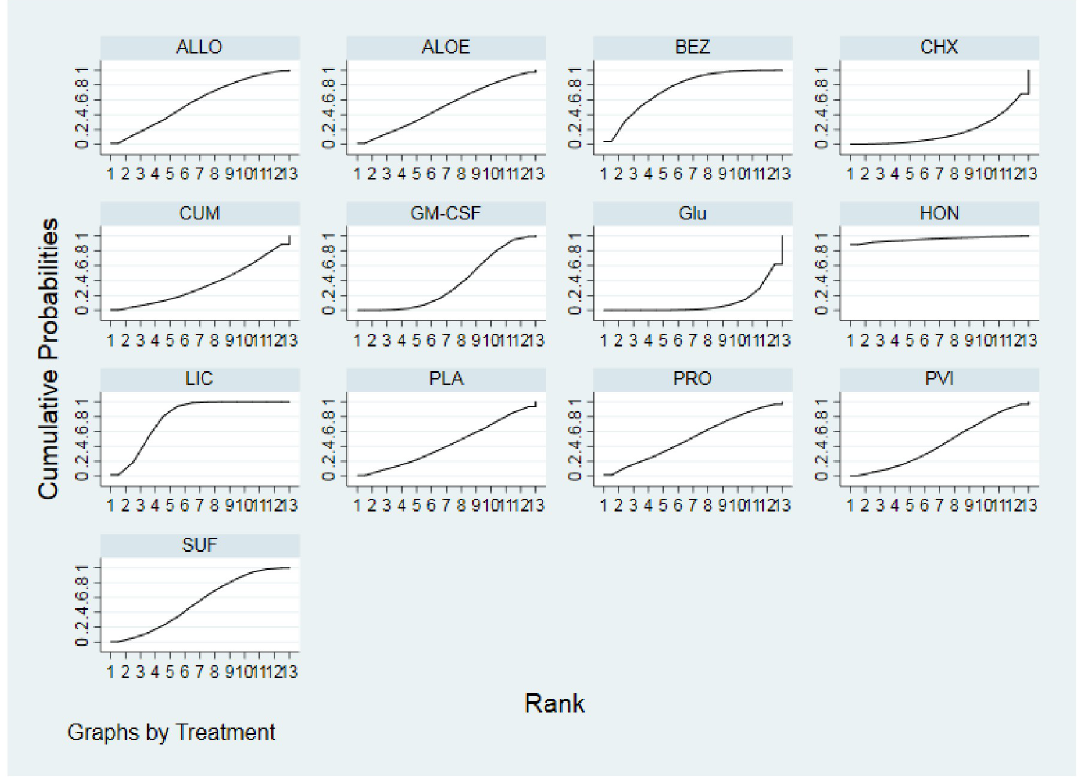
Fig 3. Rankograms for the network shows the probability of the incidence of moderate-severe oral mucositis of each treatment in patients with cancer. Abbreviation: ALOE, aloe; ALLO, allopurinol; BEZ, benzydamine; CHX, chlorhexidine; CUM, Curcumin; Glu, glutamine; GM-CSF, granulocyte-macrophage colony-stimulating factor; HON, honey; LIC, lignocaine; PLA, placebo; PRO, probiotics; PVI, povidone-iodine; SUF, sucralfate.